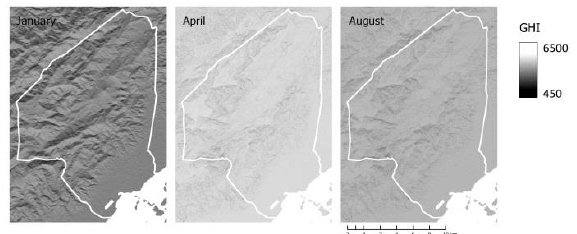
Figure 3. GHI in W/m 2 in Cebu City for representative months of the three different